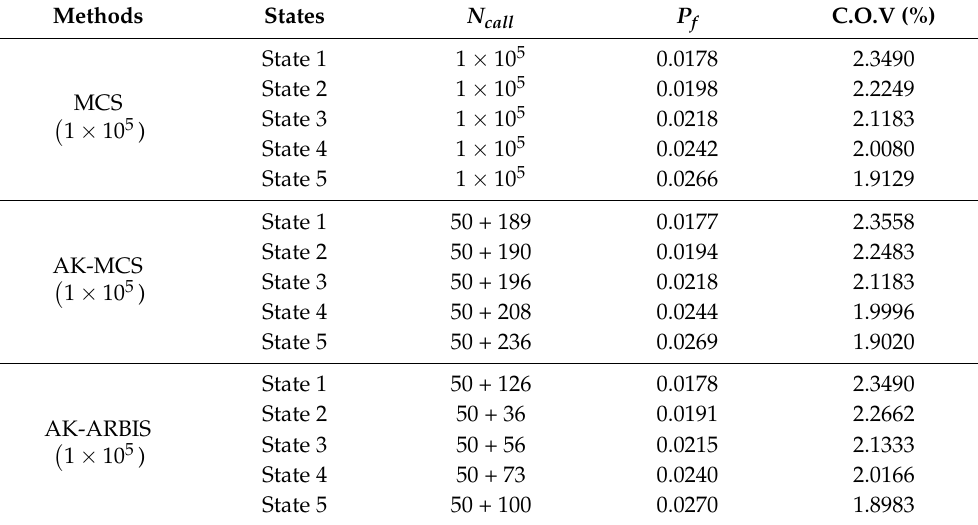
Table 5. Calculation results of a steering